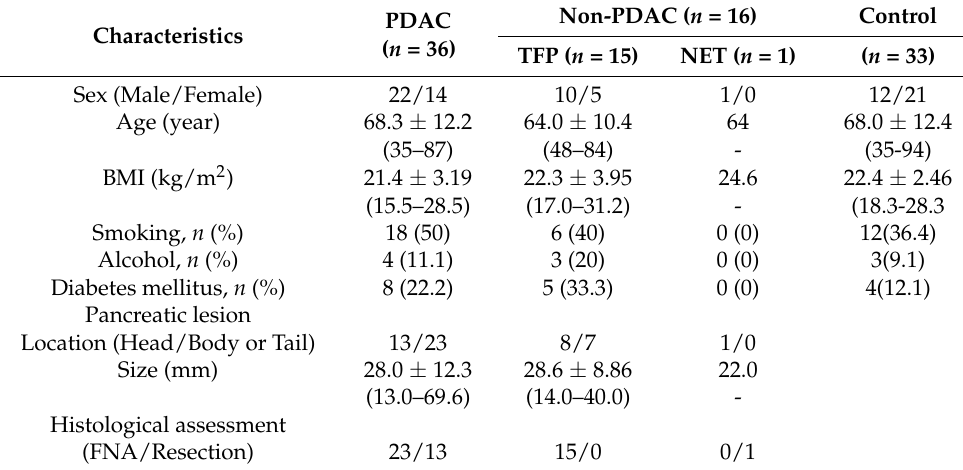
Figure 2. A total of 62 patients with pancreatic tumor lesions and 37 control subjects were screened. In the former group, 10 patients were not eligible for the inclusion criteria (5 patients whose non-tumor pancreatic parenchyma was not sufficiently detected for SWE measurement because of the presence of pancreatic head tumor, 3 patients with surgical history, 1 patient without historical diagnosis, and 1 patient whose pancreatic tumor was not clearly detected by B-mode ultrasound (US)). In the latter group, 2 cases had surgical history and 2 cases had no laboratory data. Finally, a total of 52 patients with pancreatic tumor lesions and 33 control subjects were included in the study. Table 1. Patient characteristics.